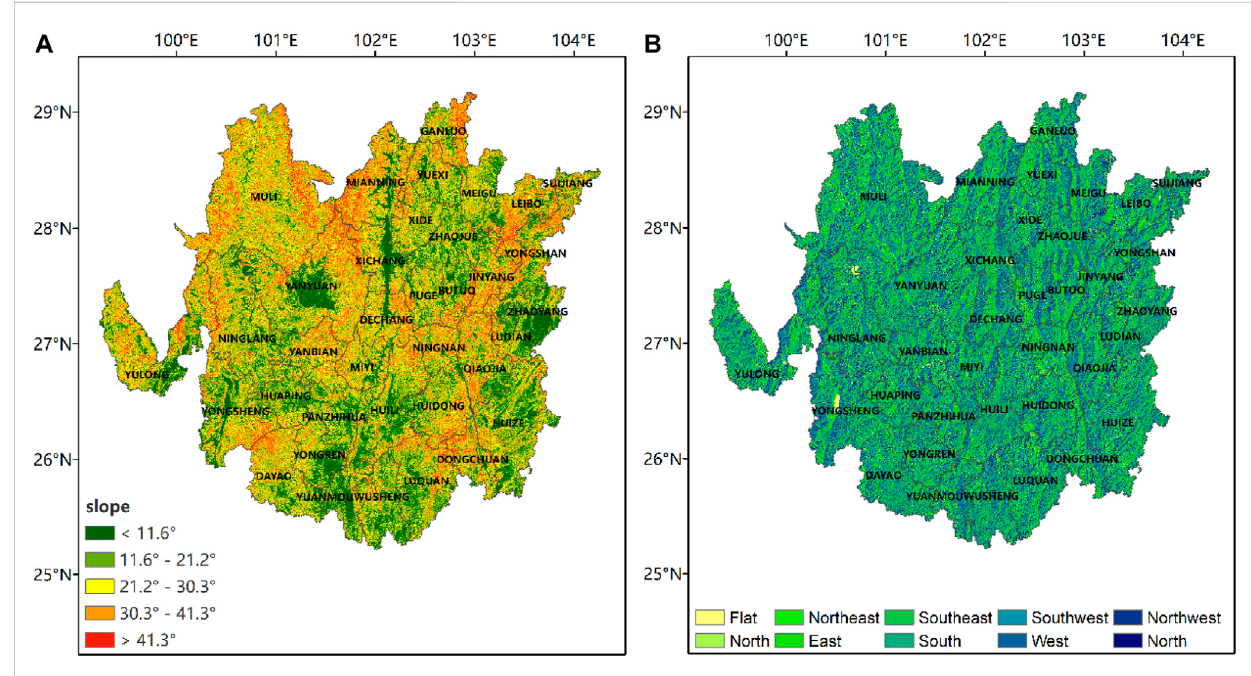
FIGURE 3 Spatial pattern of topography hazard factors over the high-wild fi re incident area in southwestern China. (A) Slope. (B) Aspect.